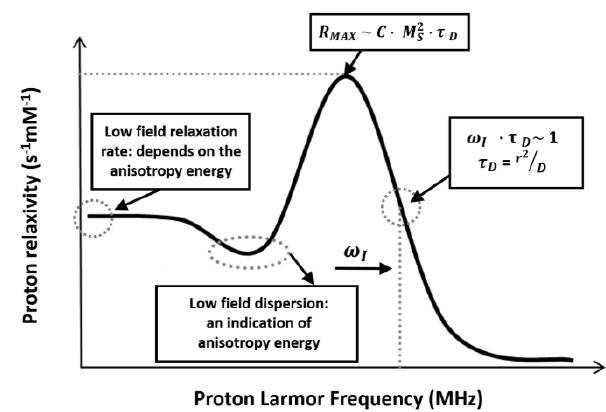
Figure 24. Nuclear magnetic relaxation dispersion (NMRD) profile of magnetite particles in colloidal